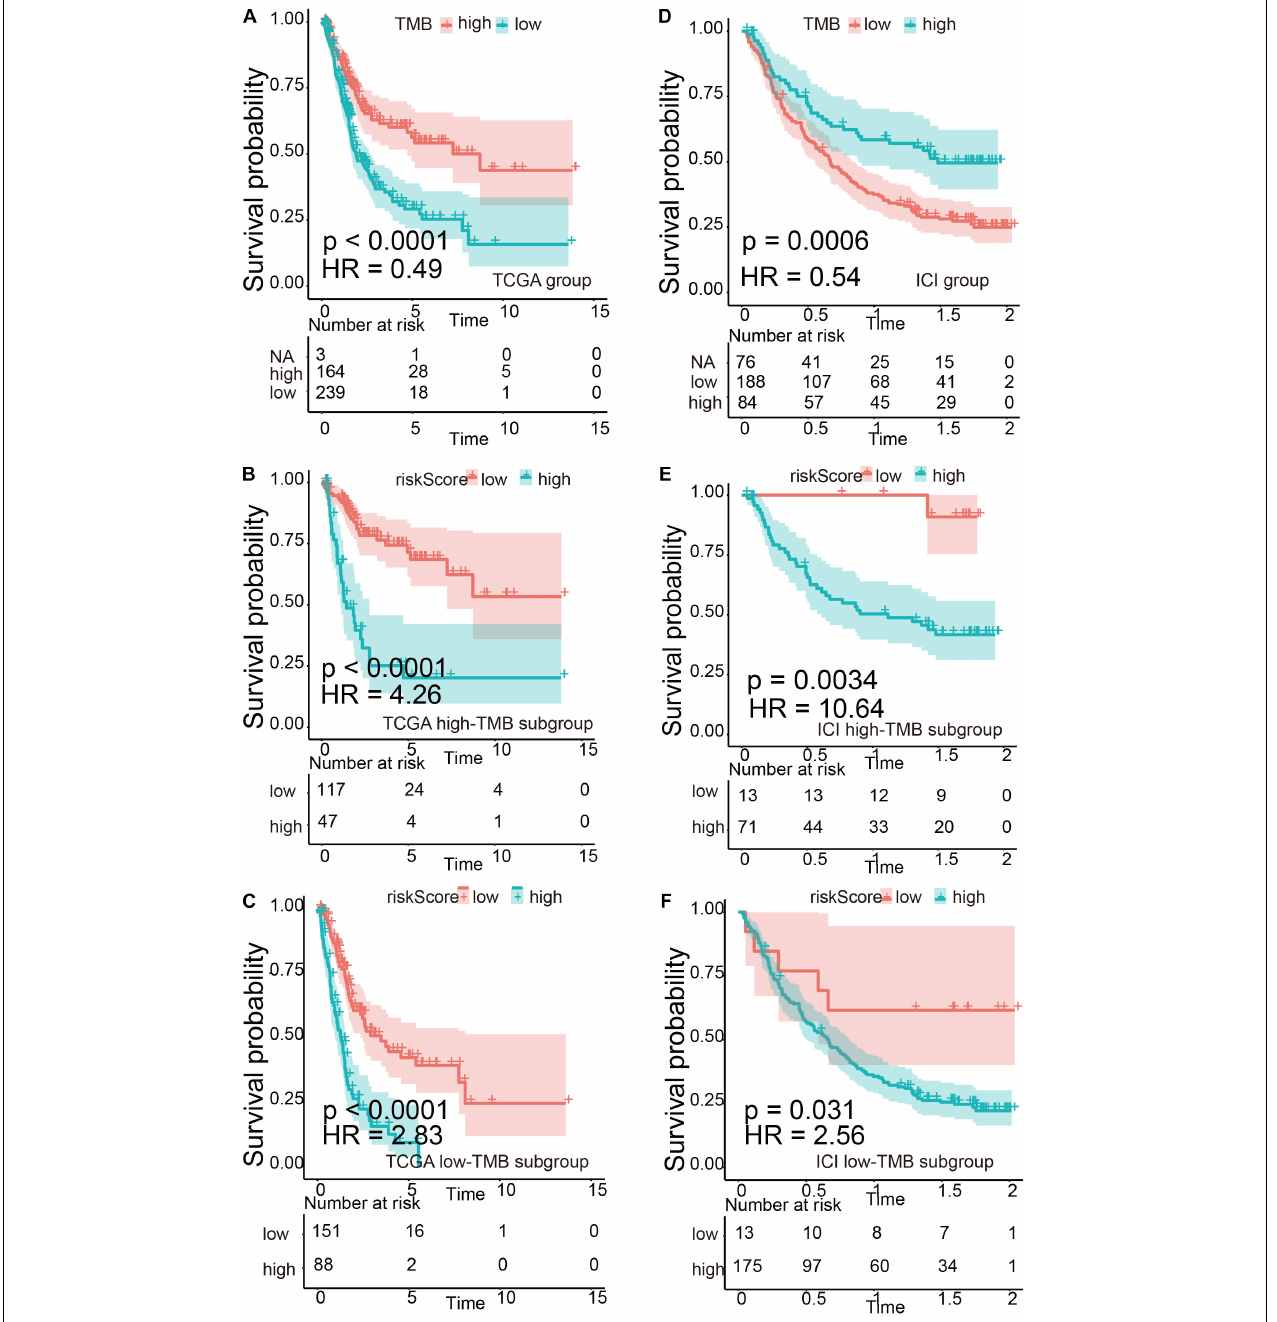
FIGURE 5 | Verification of the risk signature to be used as a stable predictor. (A–C) Kaplan–Meier survival analysis based on tumor mutational burden (TMB) levels and TMB subgroups in The Cancer Genome Atlas (TCGA) data set. (D–F) Kaplan–Meier survival analysis based on TMB levels and TMB subgroups in the immune checkpoint inhibitor (ICI) treatment